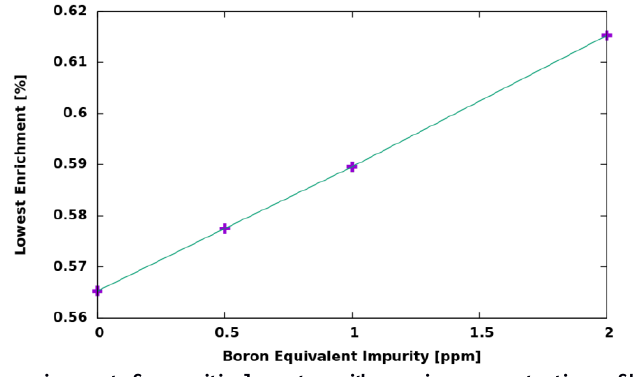
Figure 2. Enrichment requirements for a critical reactor with varying concentrations of boron in the graphite.